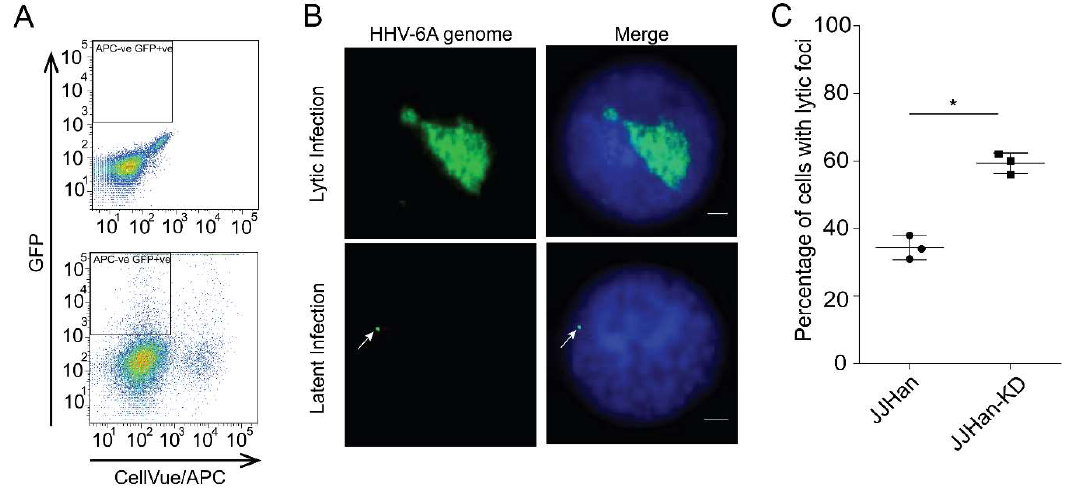
Figure 3. Quantification of lytic replication in JJHan-KD cells. ( A ) Gating strategy to isolate pure HHV-6A infected cell population. Infected GFP positive target cells were sorted and subsequently analyzed by FISH. ( B ) Representative FISH images showing the HHV-6A genome (green) in interphase nuclei (DAPI, blue) in lytically and latently infected cells. In latently infected cells, the viral genome is indicated with an arrow (scale bars correspond to 3 μm). ( C ) The percentage of lytically infected cells was quantified in JJHan and JJHan-KD cells ( n = 100) in a blinded manner. Results are shown as the mean of three independent experiments with standard errors (*, p < 0.05).